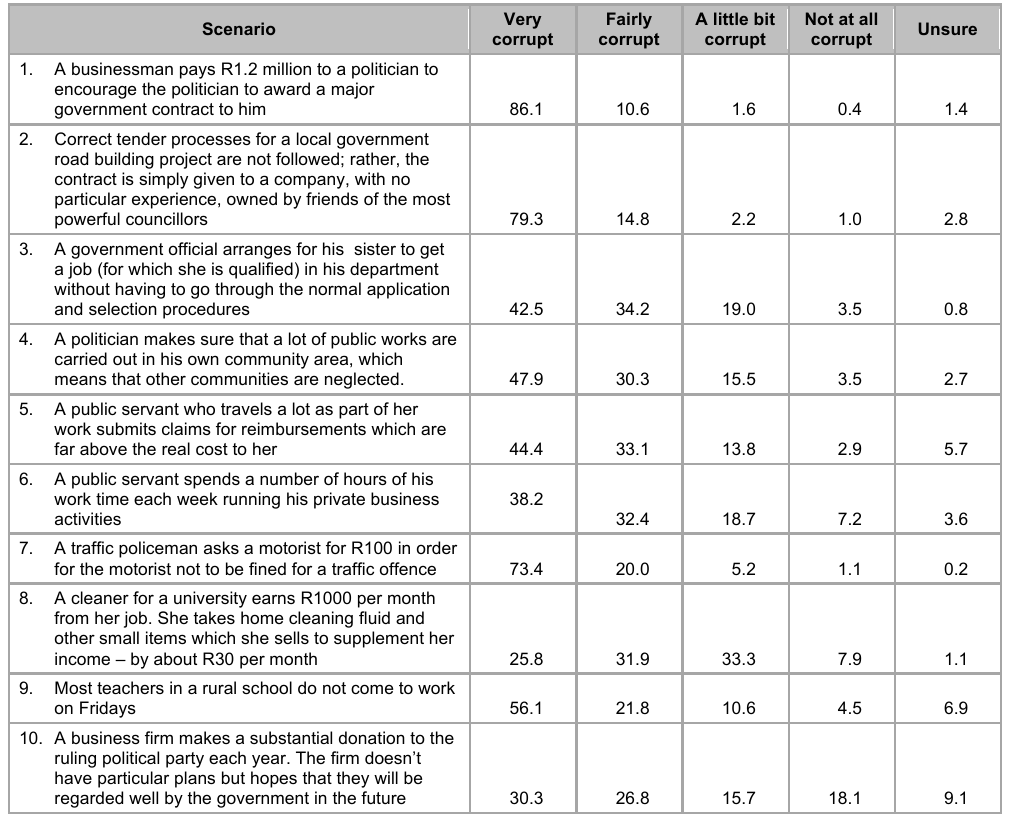
Perceptions of the degree of corruption involved in the 10 scenarios (per cent) Scenario